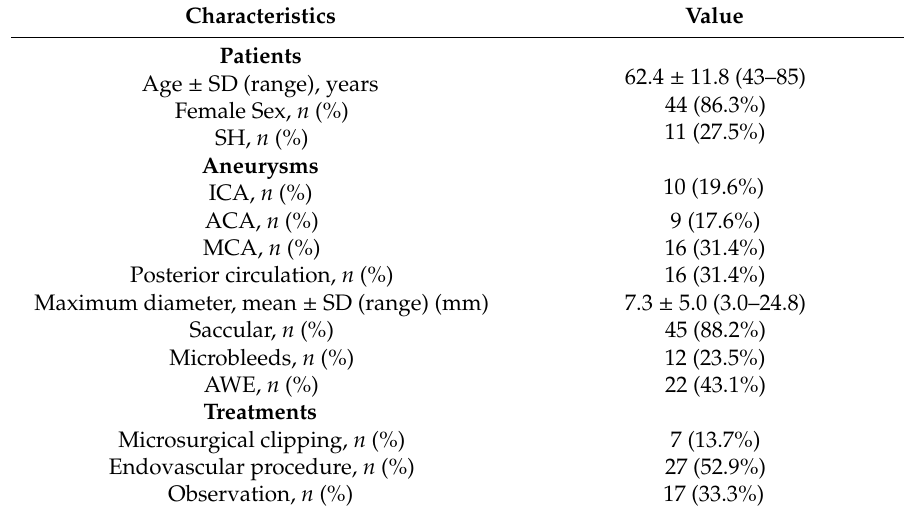
Table 1. Patient demographics and intracranial aneurysm (IA) characteristics.